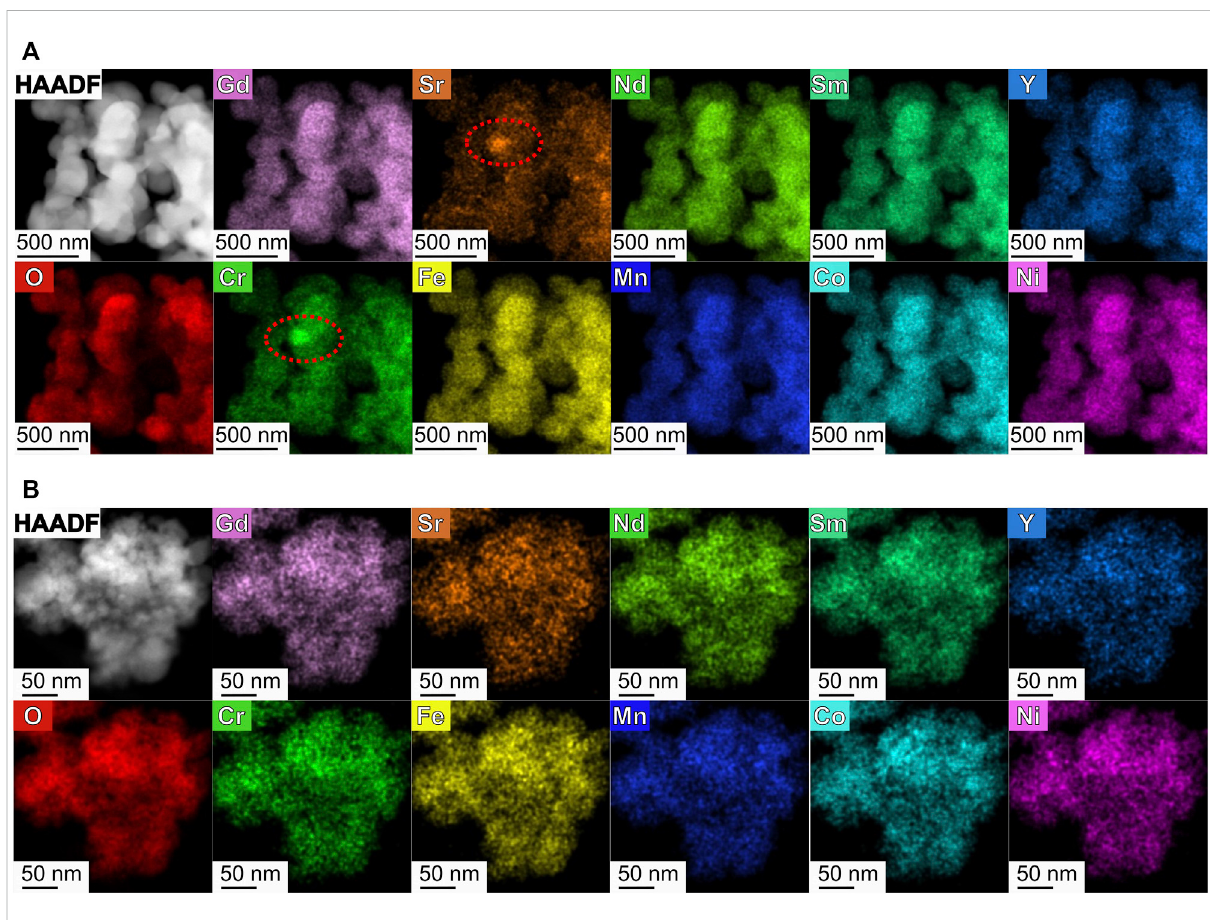
FIGURE 8 HAADF images and EDX analysis (A) HEO-Sr_PM and (B) HEO-Sr_BM. Elemental segregations in HEO-Sr_PM are highlighted by red dashed circle. HEO-Sr_PM were calcined at 1,200 ° C for 12 h in